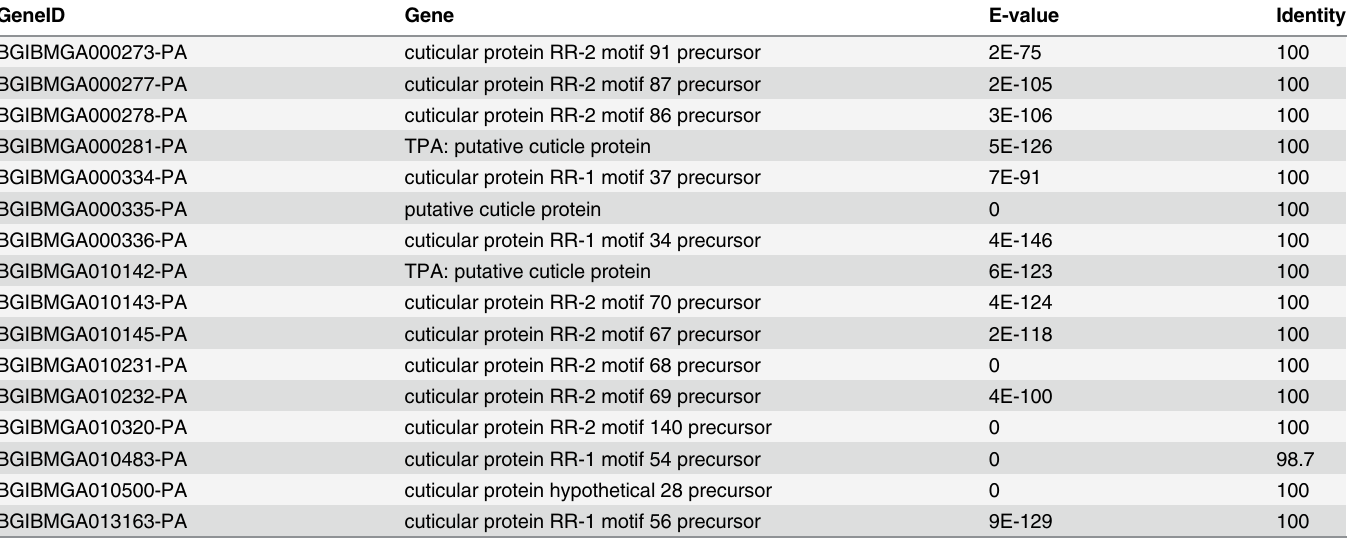
Table 5. Up-regulated genes that are involved in cuticle protein synthesis in the ASG. GeneID Gene